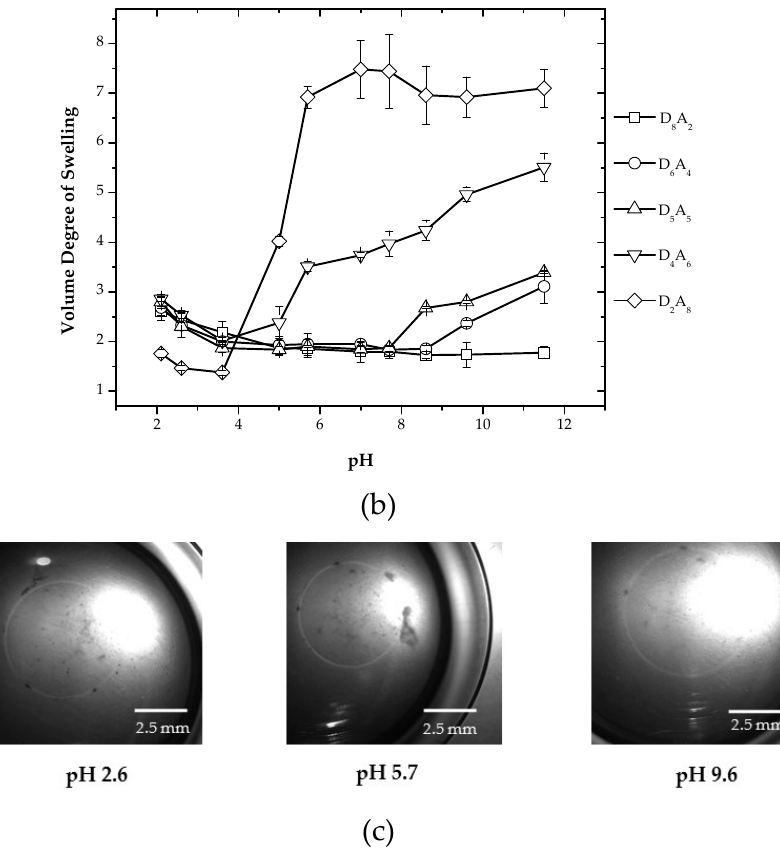
Figure 2. ( a ) Chemical composition of System II hydrogels in different pH states; ( b ) variation of the volume degree of swelling for different compositions of hydrogels; ( c ) optical micrographs showing the change in diameter of D 5 A 5 hydrogels at pH 2.6, 5.7 and 9.6